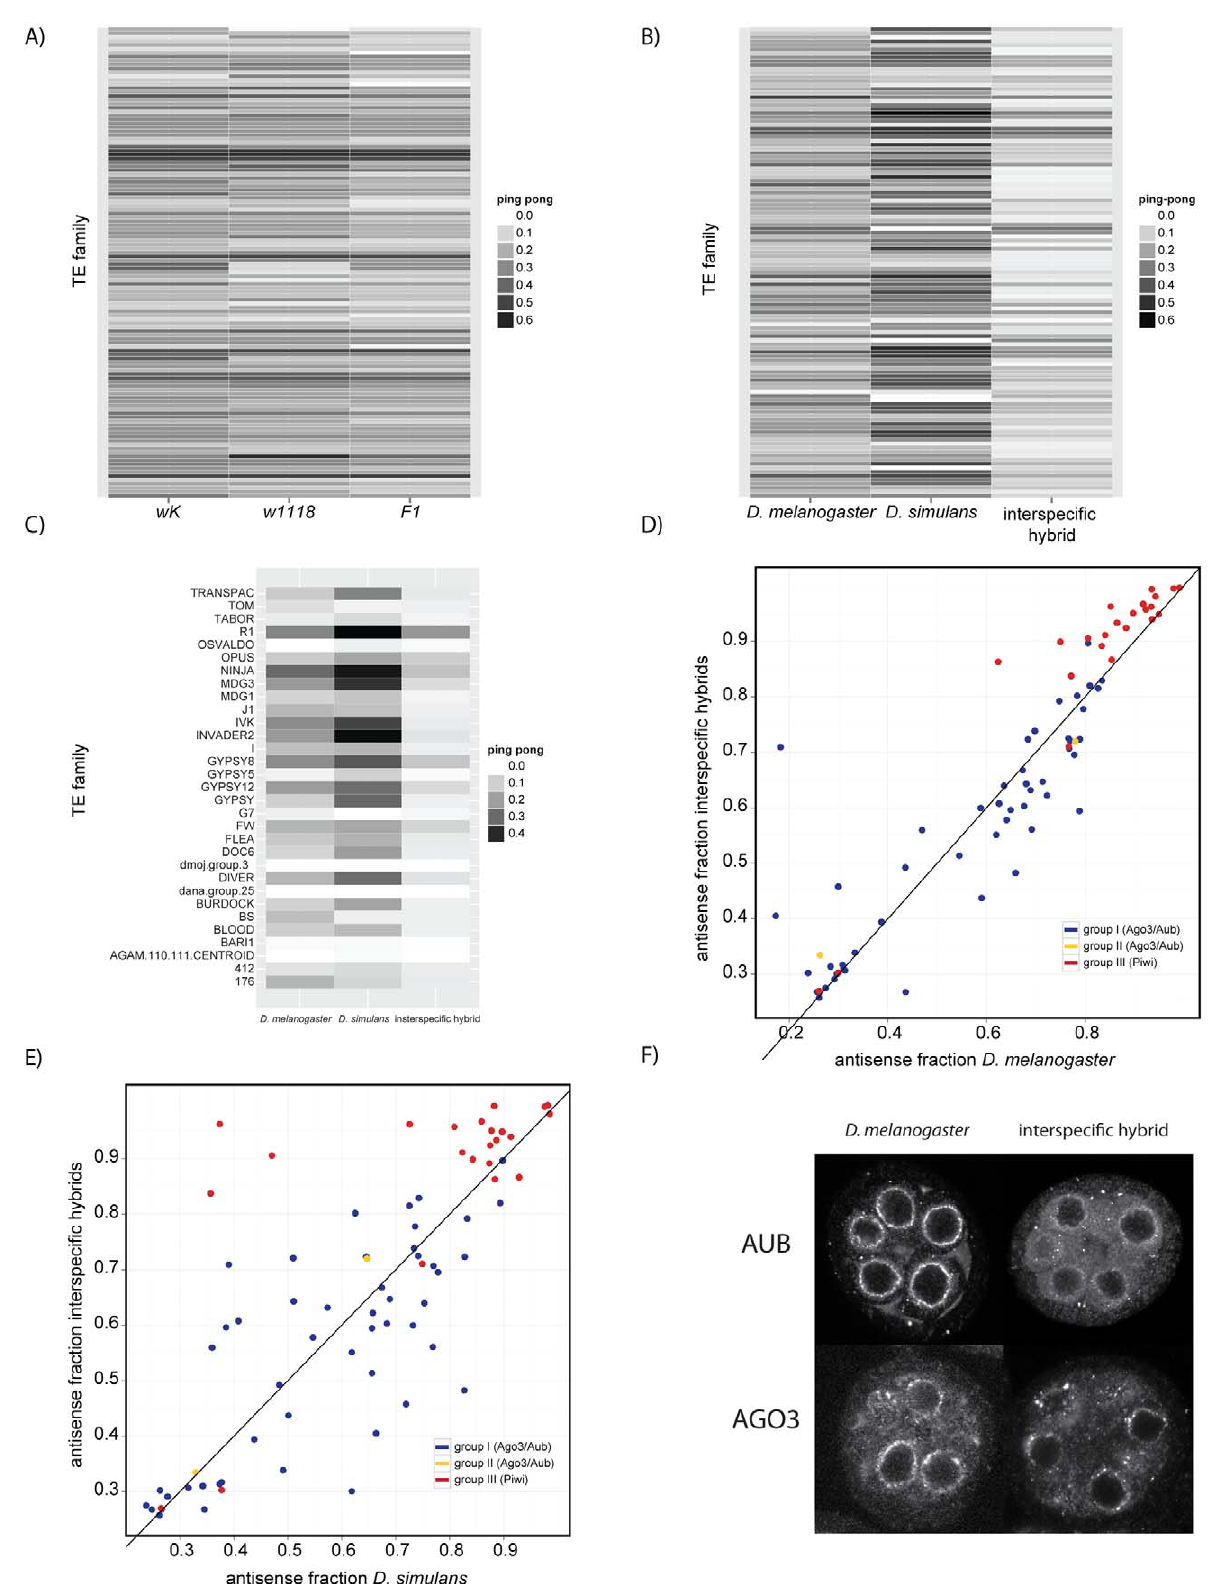
Figure 6. Interspecific hybrids phenocopy piRNA pathway mutants in disrupted piRNA production and nuage mislocalization. (A and B) Aberrant ping pong fractions in interspecific but not intraspecific hybrids. Ping pong fractions [23] for all TE families are compared between intraspecific hybrids and their parents (A) and interspecific hybrids and their parents (B). Only TE families that were represented by . 50 small RNA PLOS Biology |